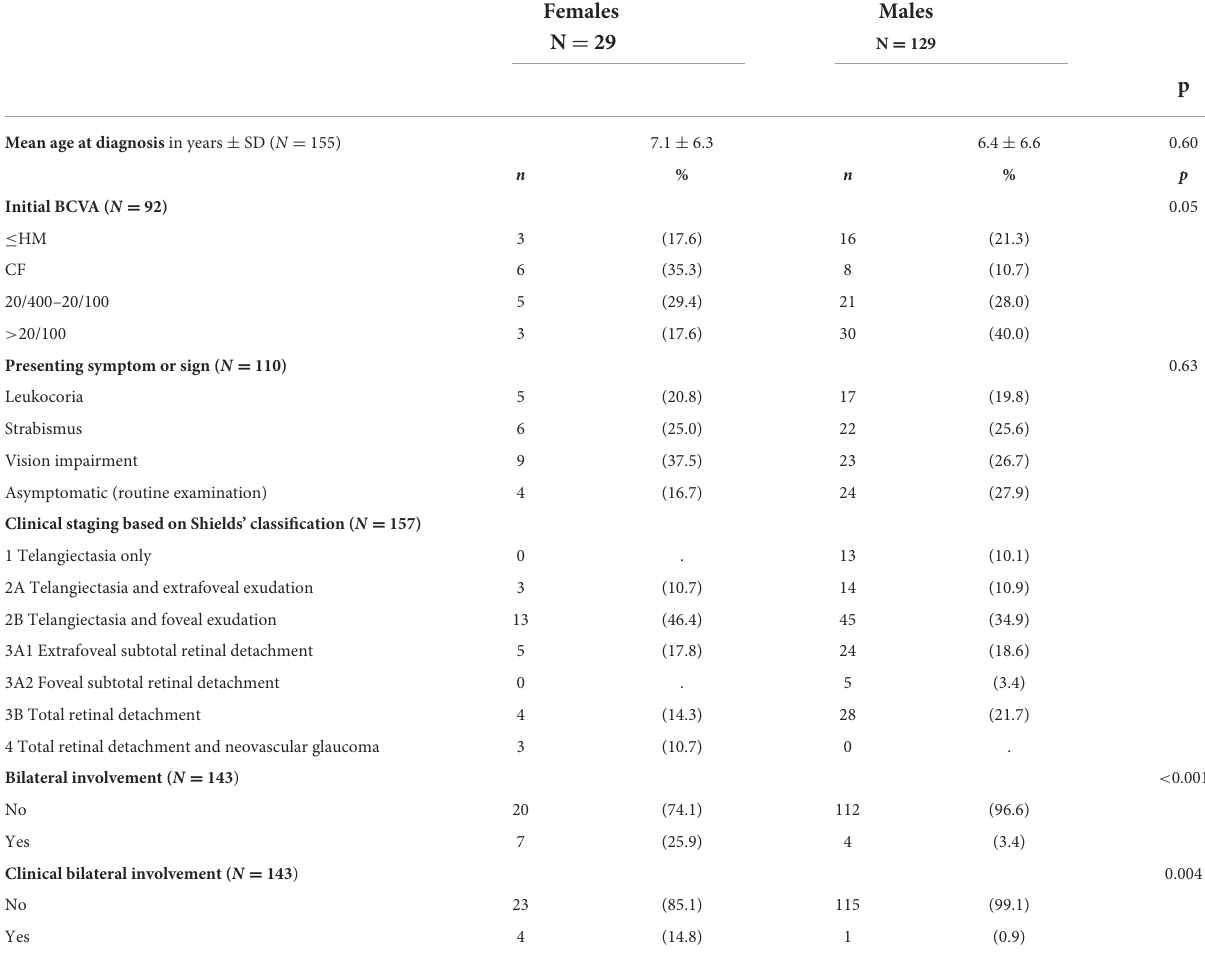
TABLE 1 Comparative analysis of baseline characteristics between males and females.